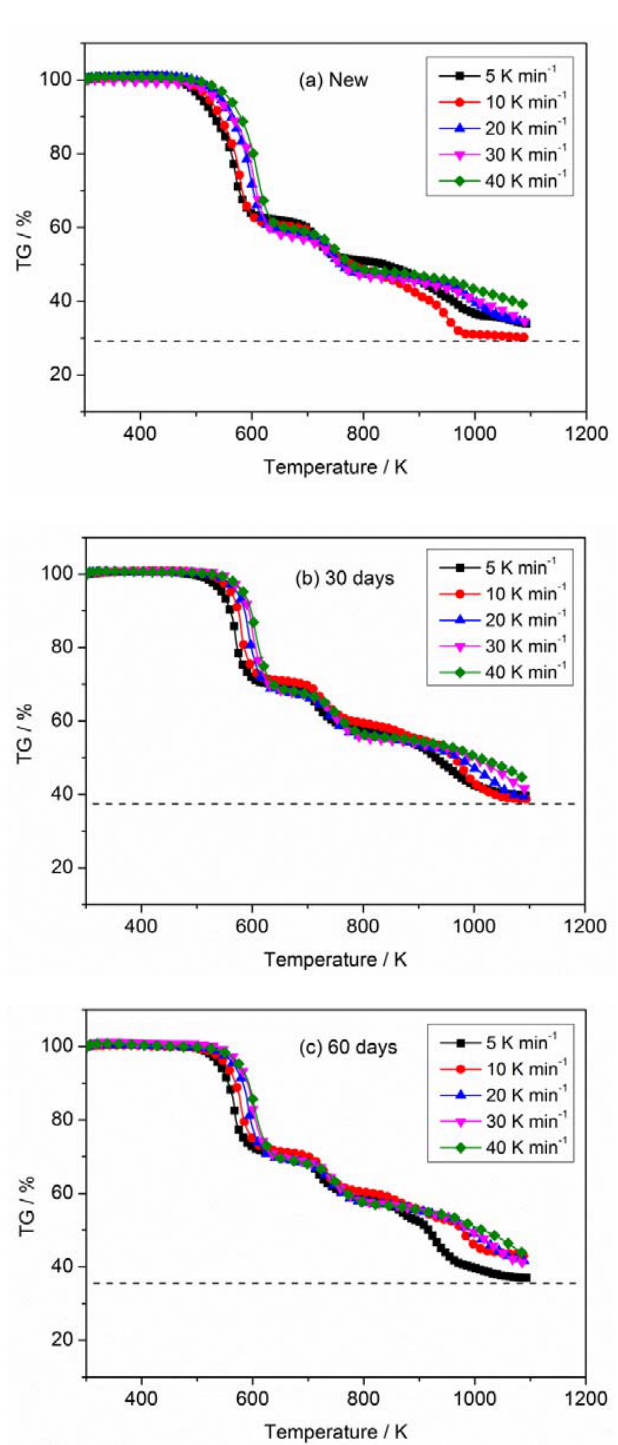
Figure 2. Mass loss (thermogravimetric analysis (TG)) curves of PVC sheaths at different heating rates in nitrogen atmosphere: ( a ) new; ( b ) aged 30 days and ( c ) aged 60 days.